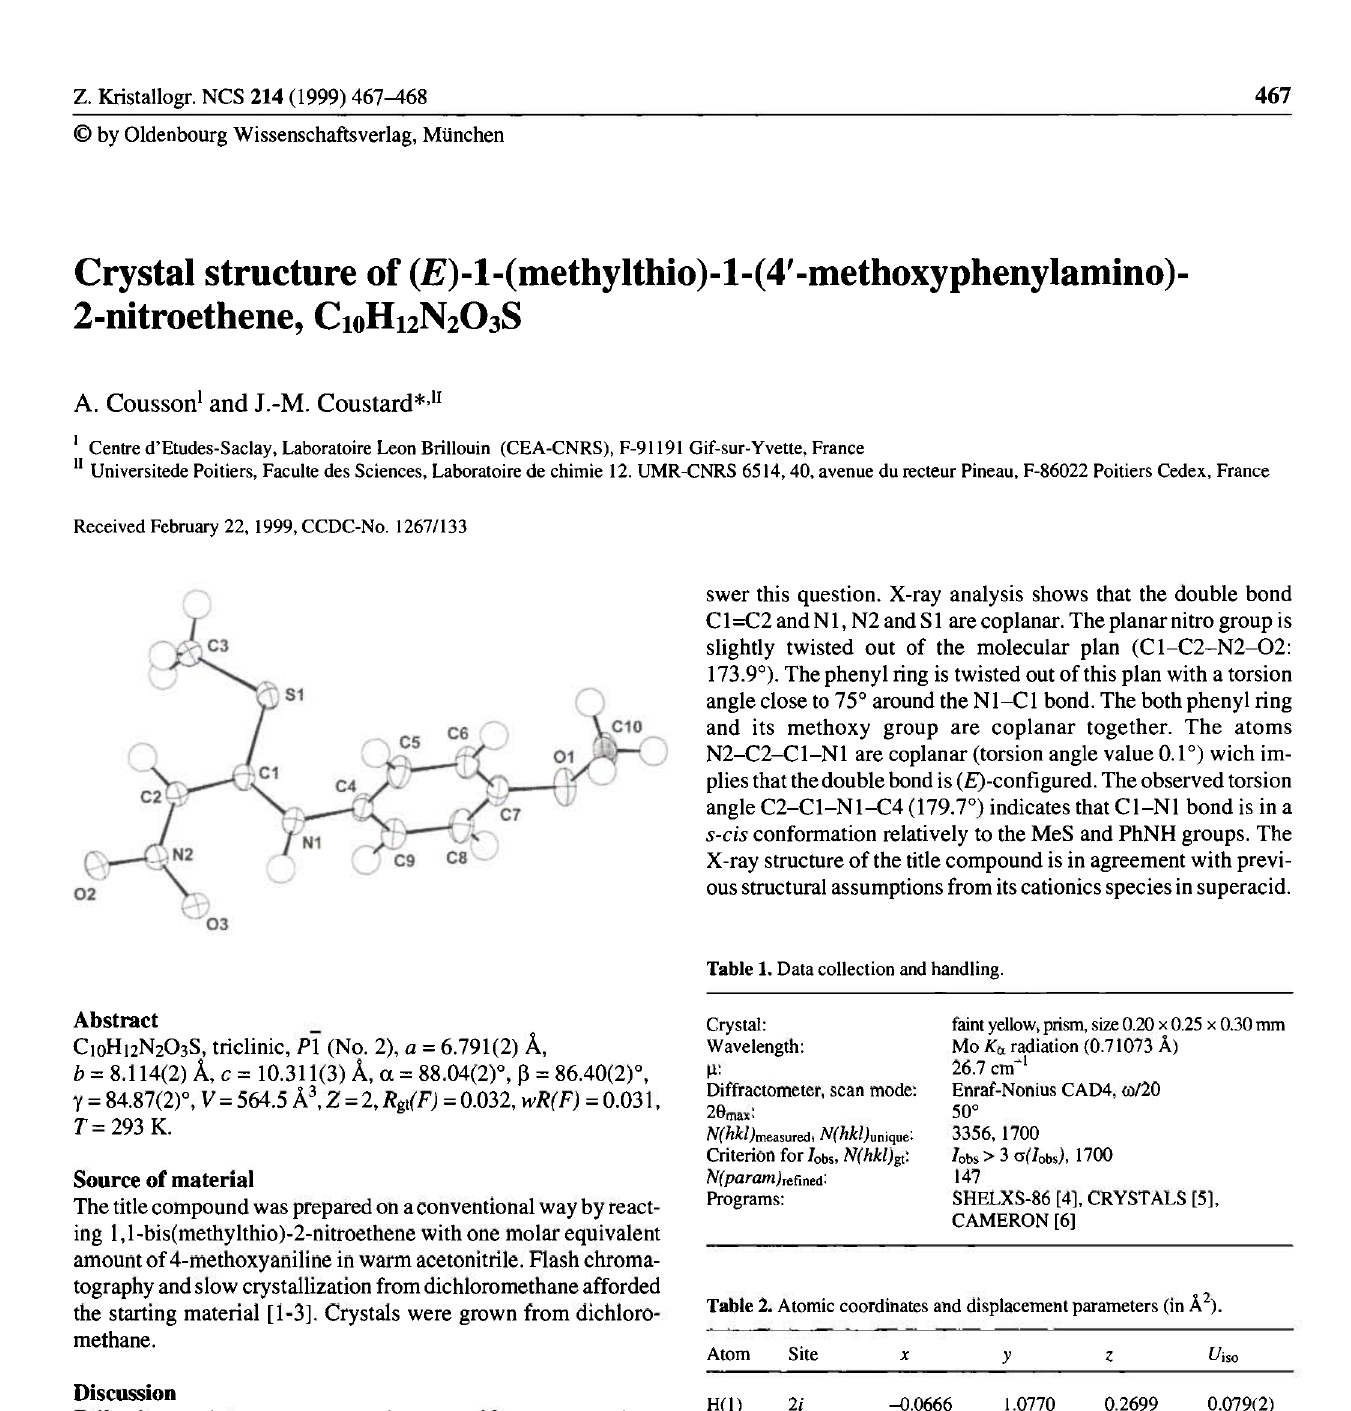
Table 2. Atomic coordinates and displacement parameters (in Ä 2